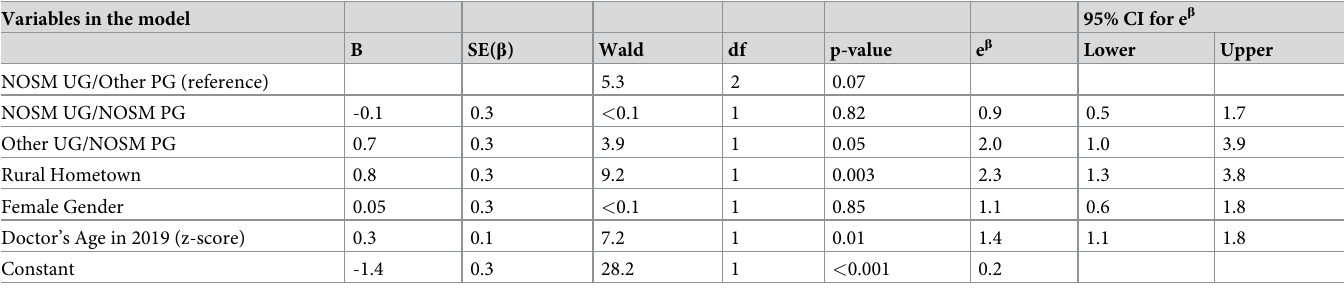
Table 4. Logistic regression model to predict rural practice location of 334 family doctors � . Variables in the